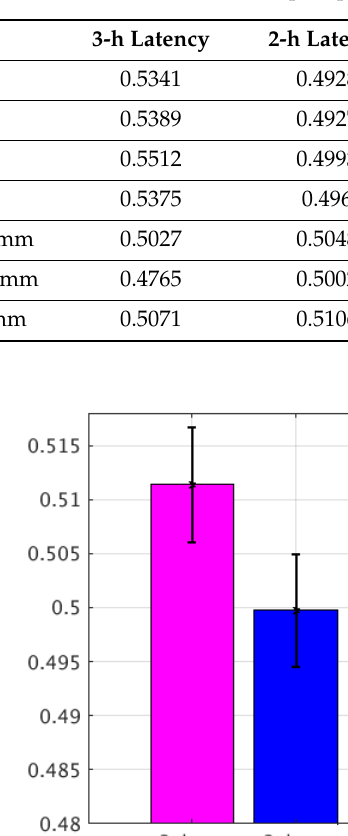
Table 5. The normalized RMSE for T / Q / U / V and precipitation scores for the four experiments of Case II.